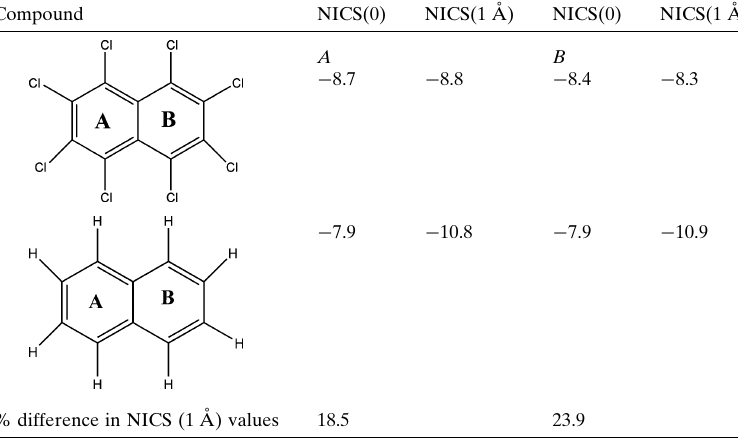
Table 3 Dissected NICS (in p.p.m.) at ring centres and 1 A˚ above.